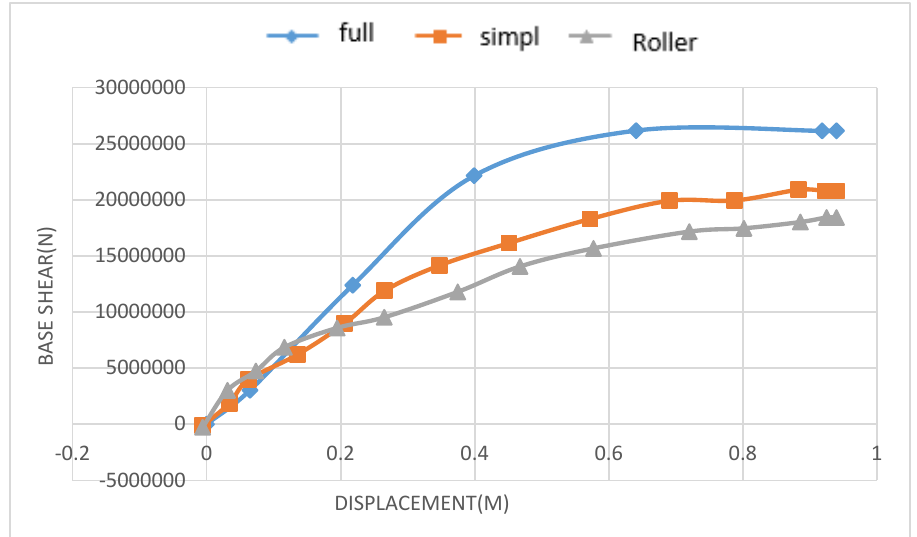
Fig. 16. 6 spans bridge with base height 6 meters in longitudinal